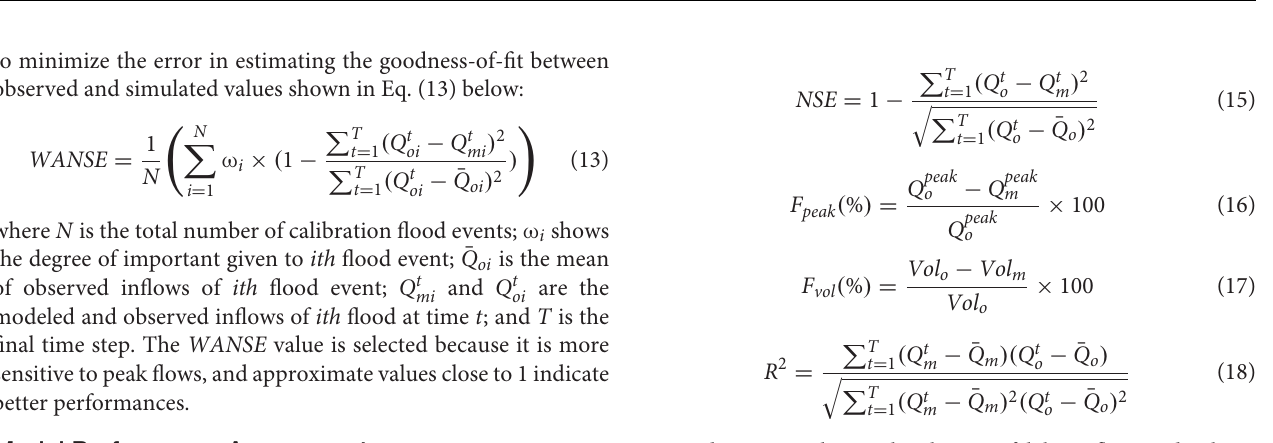
FIGURE 2 | Technique path map of the research. Fr: contribution area; RB: runoff of impervious area; S: free water; QS: total surface runoff; QI: total interflow; QG: total groundwater runoff; Other parameter meanings can be seen in Supplementary Table 1